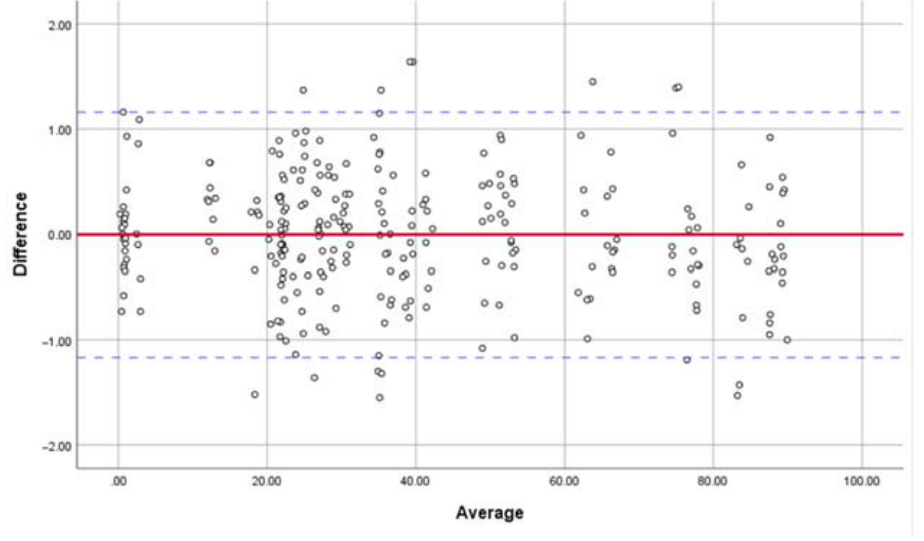
Figure 9. The Bland–Altman plot analysis was used for investigating the inter-observer agreement in locating the mandibular measurement landmarks and measuring the linear dimensions, which indicated great reproducibility.